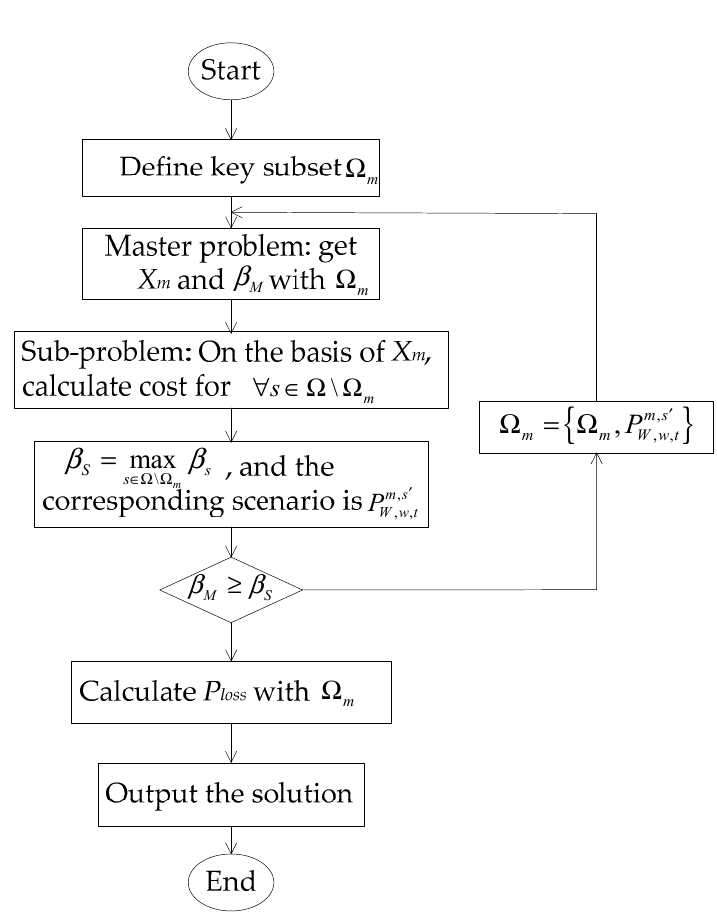
Figure 3. Flow chart of the iteration method.